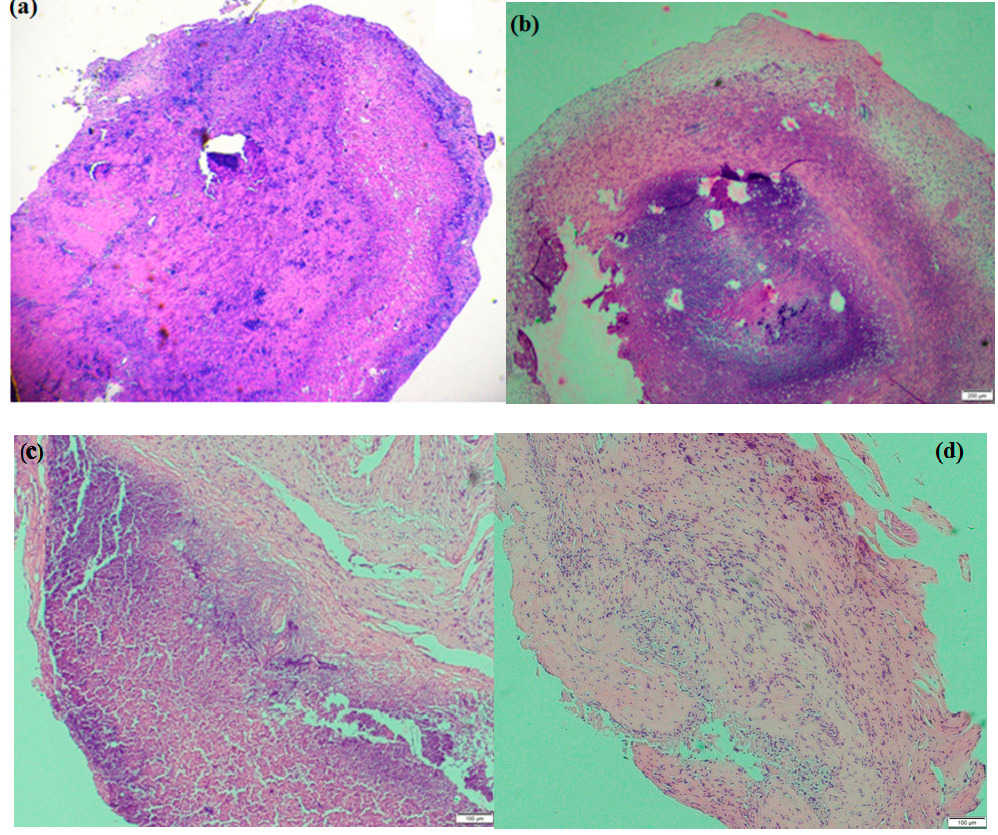
Figure 9. Histological tissue H&E analysis of after treatment: Hep-F127 ( a ), NaCl ( b ), Hep-F127/CDDP ( c ) and Hep-F127/CDDP/Cur ( d ).